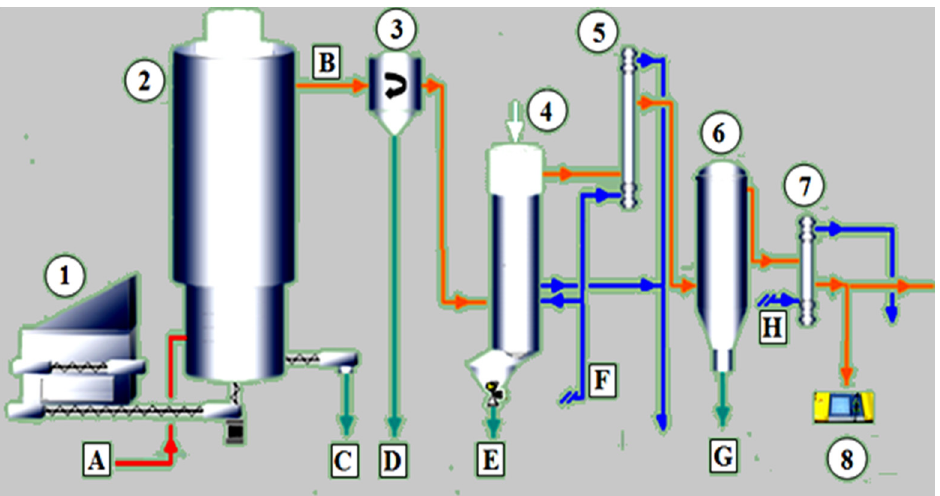
Figure 2. Diagram of the biomass gasification plant: 1 —pellet dispenser, 2 —reactor, 3 —cyclone separator, 4 —dolomite reactor, 5 —water cooler, 6 —high temperature filter, 7 —cooler, 8 —syngas